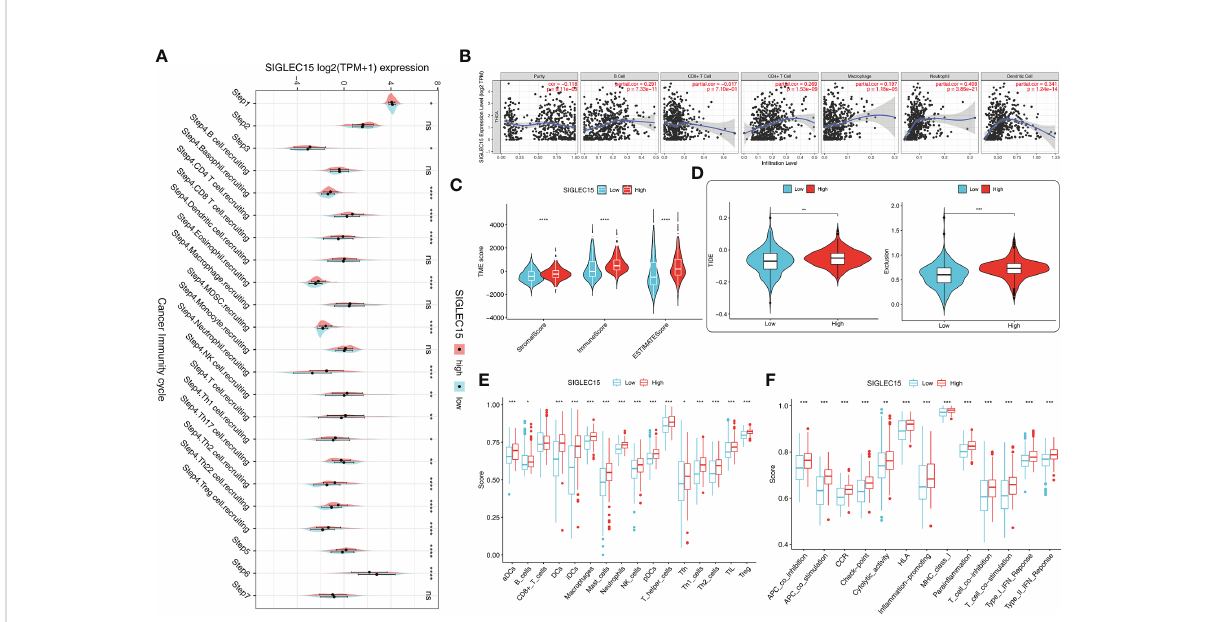
FIGURE 5 Immunological cell patterns related to SIGLEC15 . (A) Differences in the seven steps of the cancer immunity cycle between the high and low SIGLEC15 groups. (B) SIGLEC15 was associated with immune cell in fi ltration in THCA obtained from the TIMER database. (C) TME scores were compared between the high and low SIGLEC15 groups. (D) Scores were compared between the low and high SIGLEC15 groups in TIDE score and Exclusion score. (E) Enrichment scores for 16 immunocytes were compared between the low and high SIGLEC15 groups. (F) Enrichment scores for 13 immune-related pathways were compared between the low and high SIGLEC15 groups. ns, *, **, ***, and **** stand for p-value >0.05, p-value <=0.05, p-value <=0.01, pvalue <=0.001 and pvalue <=0.0001,